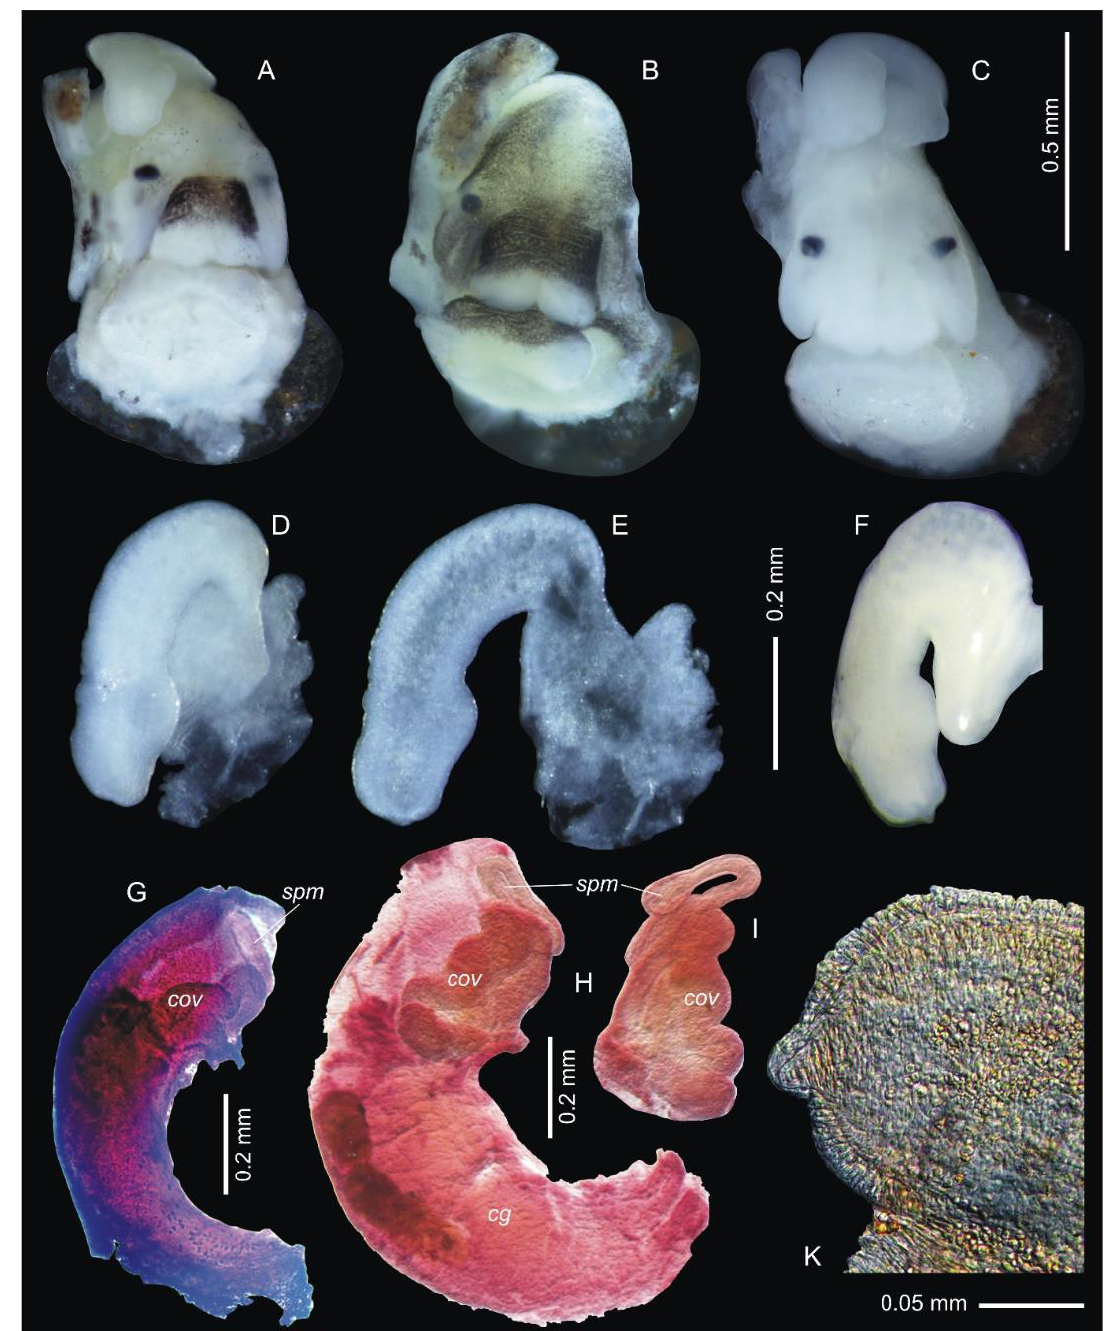
Figure 9. The soft body and details of the Clathrocaspia male and female reproductive system: ( A , B , D , E , G , K ) — Clathrocaspia laevigata sp. n.: ( A , D , E ) — male, specimen IZAN 612/2, loc. Dag28 (the same individual as Figure 4K) ((A) — front view, ( D , E ) — penis); ( B ) — female, specimen IZAN 613/1, loc. Dag32 (the same individual as Figure 4Q); ( G ) — ventral view of distal part of female genital system, specimen Dag28_TS, loc. Dag28; (K) — male, specimen Dag67_LCh, loc. Dag67 (pointed pro- trusion of the penis). ( C , F , H , I ) — C. knipowitschii : ( C ) — male, specimen IZAN 522_22, loc. Kosh (front view); ( F) — male, specimen IZAN 522_13, loc. Kosh (penis); ( H , I ) — female, specimen IZAN 390_TS loc. KHS ( H — ventral view and I — dorsal view of distal part of genital system). Abbreviations as seen in Figure 10.